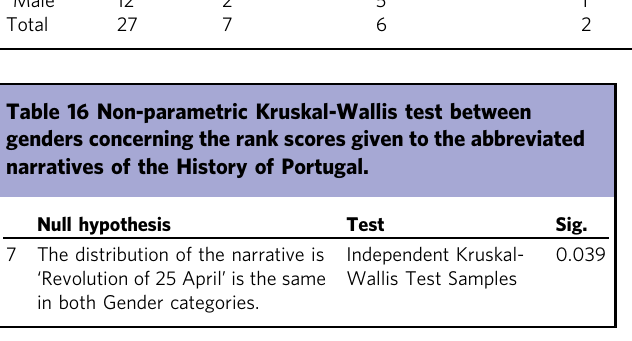
7 The distribution of the narrative is ‘ Revolution of 25 April ’ is the same in both Gender categories.